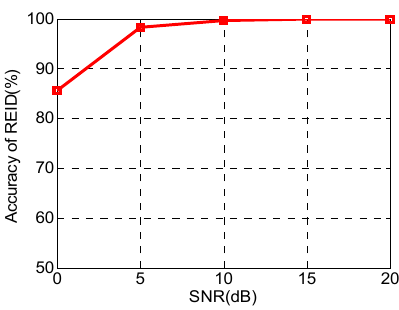
Figure 8. Accuracy of REID by using SMR in different SNRs.